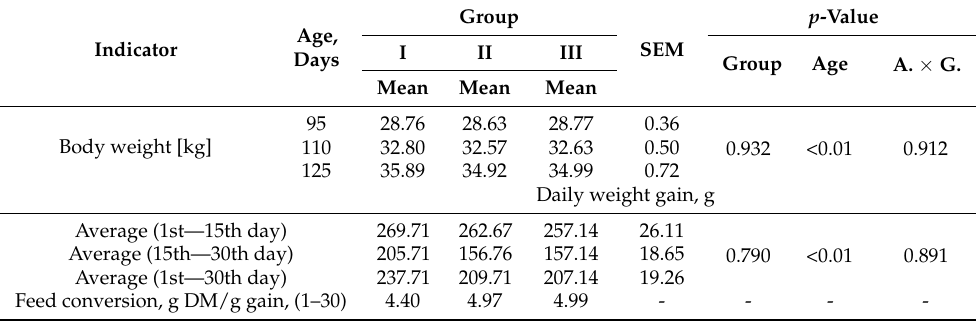
Table 2. Production traits of lambs.